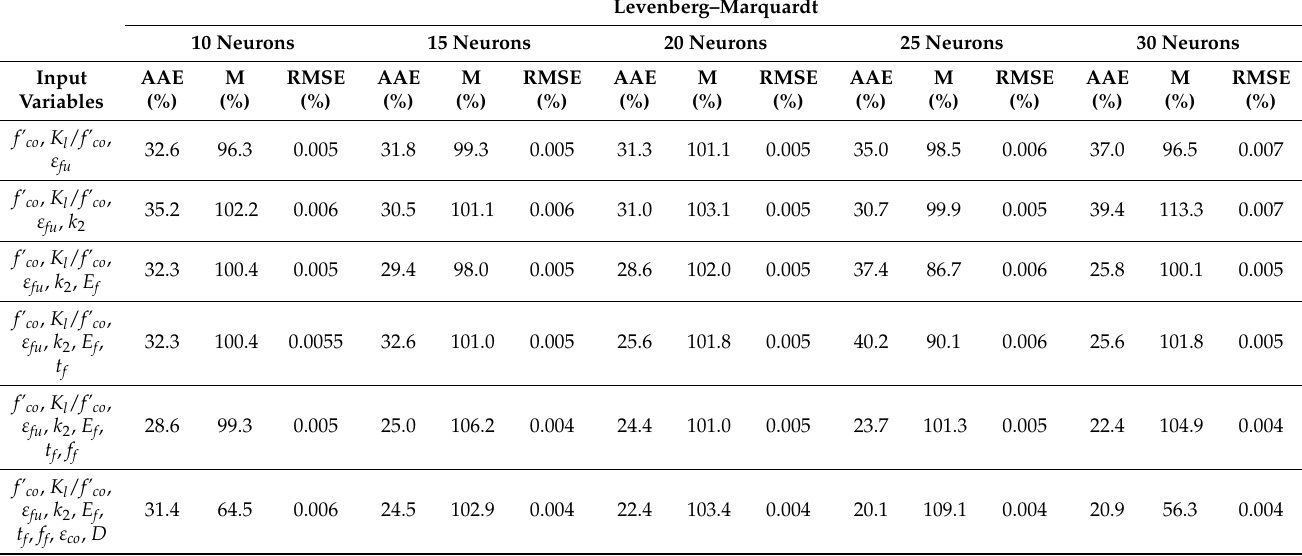
Table 7. Summary of different studied cases for input variables for ɛ cu .